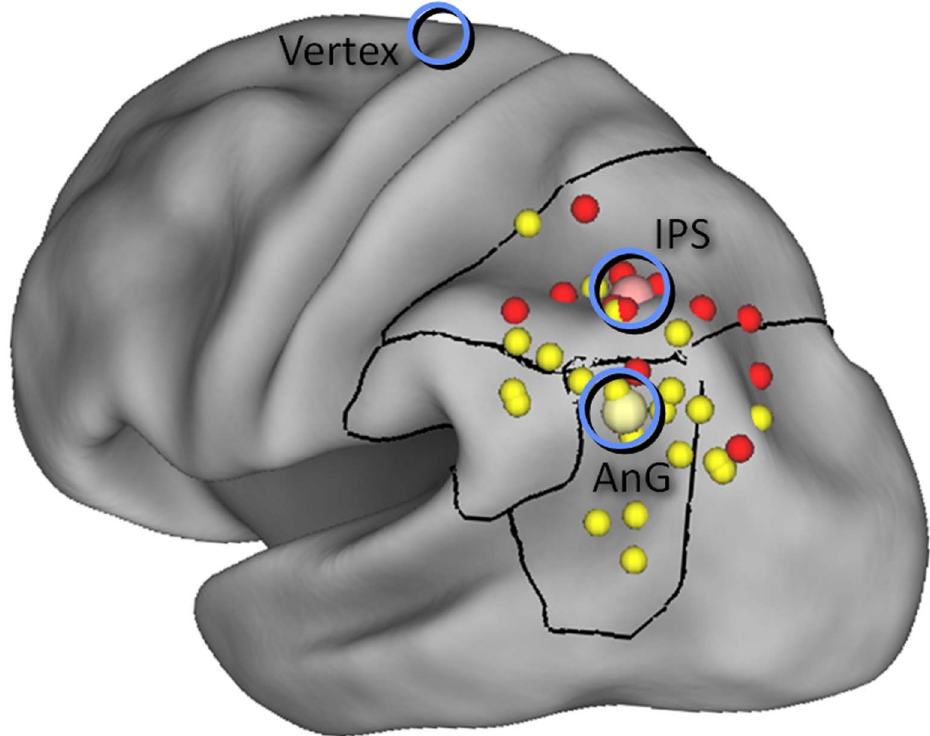
Figure 2. cTBS target locations (blue circles) displayed on an inflated fiducial brain that illustrates parietal loci sensitive to recollection (small yellow spheres) and familiarity (small red spheres), derived from a meta-analysis of fMRI studies [13] . The centers of mass of these activation clusters (large spheres) were the targets for angular gyrus (AnG) and intraparietal sulcus (IPS) stimulation. Figure adapted from one kindly provided by Mick Rugg.